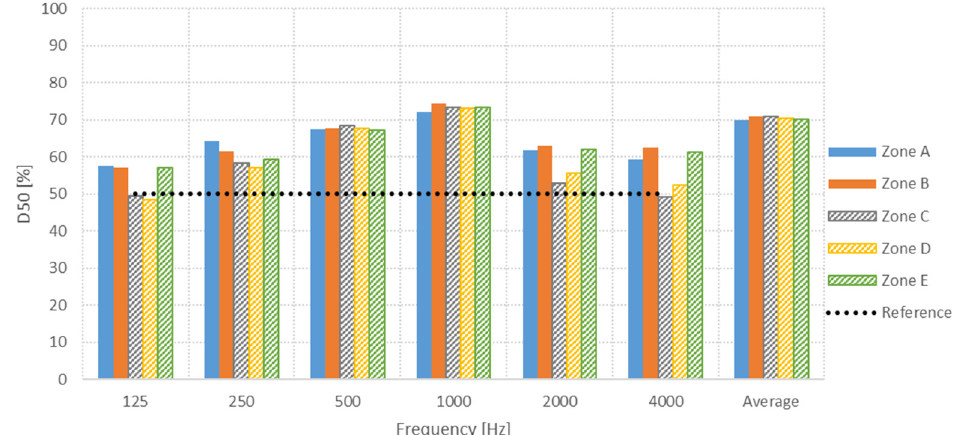
Figure 11. Definition (D50) obtained in the auditorium, when the variable acoustic solution provides maximum absorption (configuration A) for the different zones.